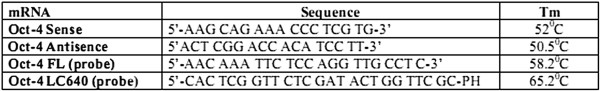
mRNA sequences for Oct-4 genes. Sense and antisense mRNA sequences for Oct-4; (Tm: Melting temperature).